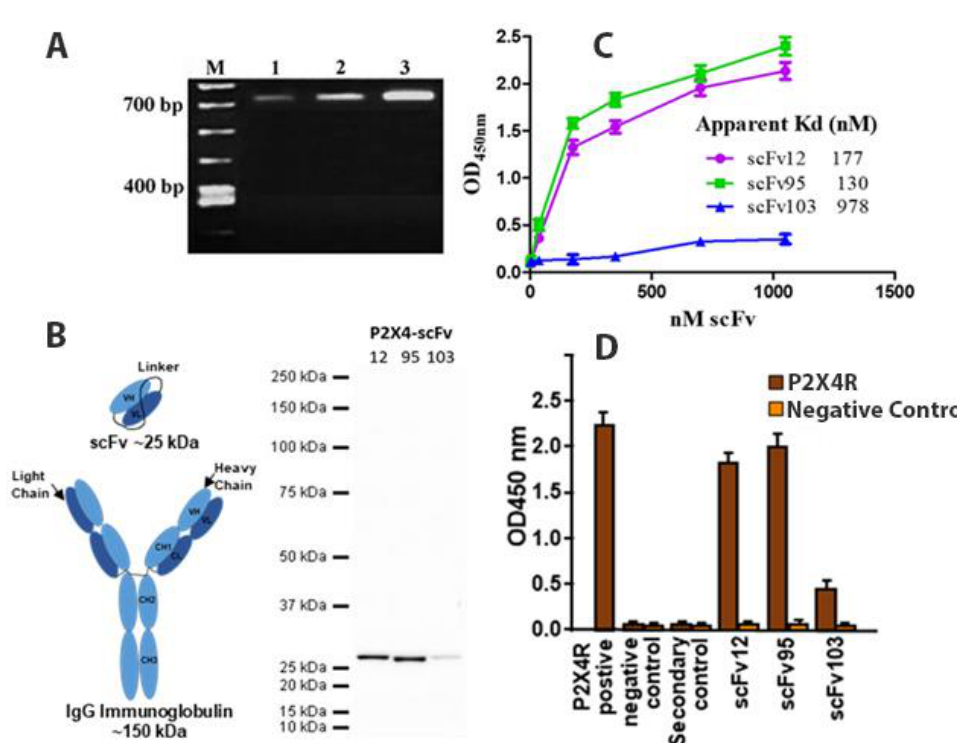
Figure 2. Isolation and binding efficacy of P2X4R scFv antibodies. ( A ). Analysis of RT-PCR recovery of V H /K cDNA from P2X4R peptide-immunized spleen in the 1st, 2nd, and 3rd cycles. ( B ). The diagram to the left illustrates the size difference between scFv and full IgG molecules. On the right are Western blots of three purified unique P2X4R scFvs generated by the cell-free ribosome display platform. ( C ). Plot of ELISA data showing nanomolar binding affinity for the three scFv antibodies with the best binding. ( D ). Binding specificity and cross-reactivity of three P2X4R scFvs to P2X4R, but not to neutral IgGs or scFvs as negative controls.